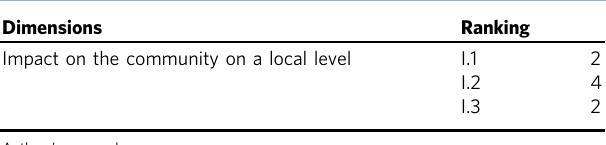
Table 21 Dimensions of the model (TB.6) and level of development for each initiative.